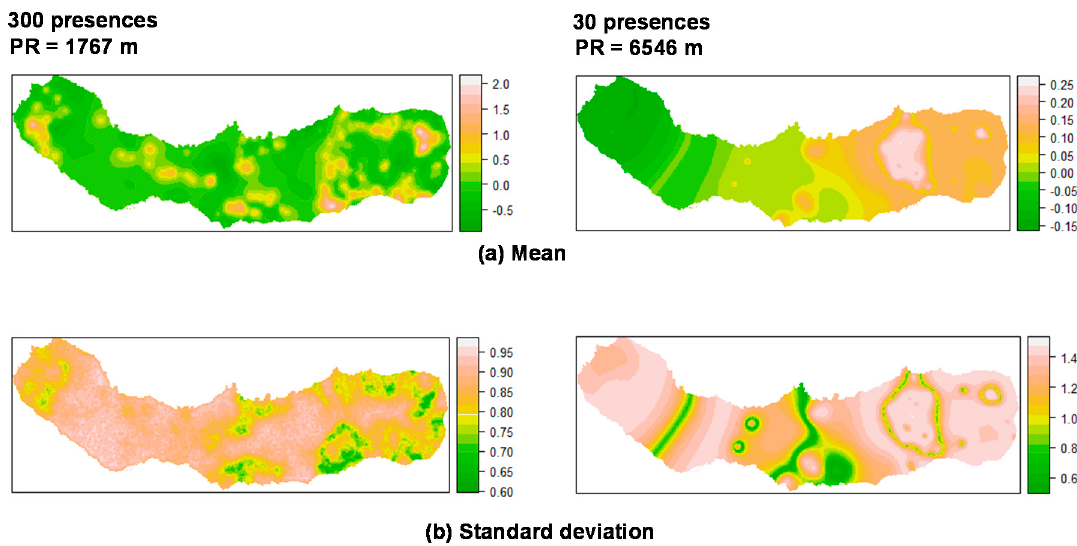
Figure 3. Summary of the spatial random effect (Gaussian random field) for the best mixed effects models and their reduction for P. undulatum in São Miguel Island. Mean ( a ); Standard deviation ( b ). PR: Practical range.